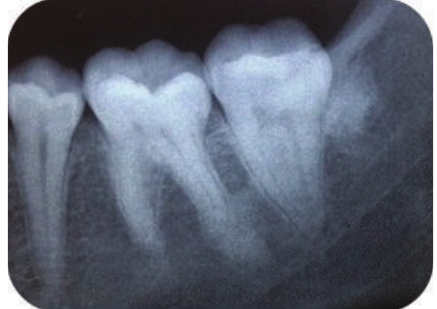
Figure 1: Intraoral view of the maxillary arch showing the small canine on the right side with signs of attrition.